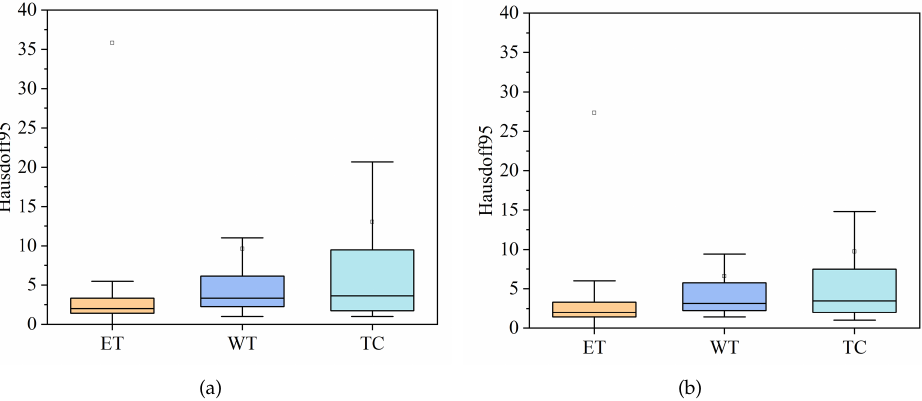
Figure 7. The boxplot of Hausdorff95 distance on the BraTS2020 validation set. ( a ) stands for HDC-Net, and ( b ) stands for